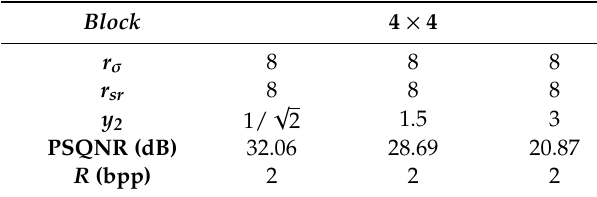
√ 2) and ( b ) a non-optimal binary